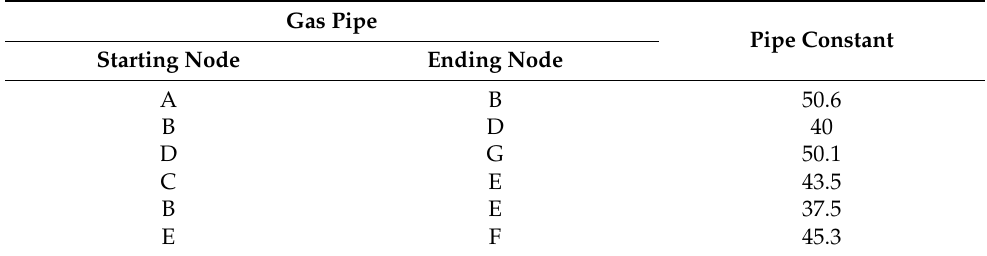
Table A1. Gas pipeline parameters. Reproduced from [30], IEEE Transactions on Power Systems: 2009.